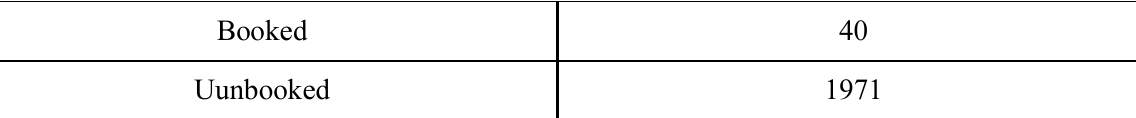
Table 2: Booking Status of the patients